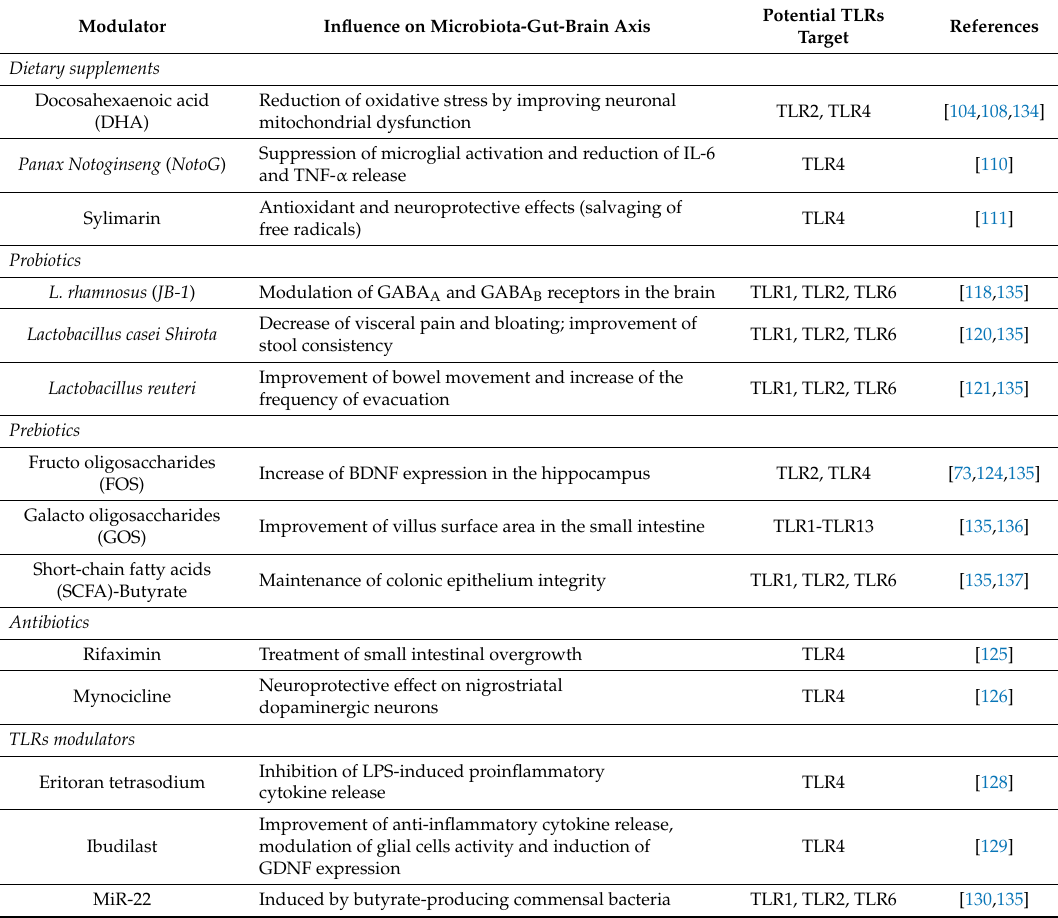
Table 1. Pharma- and/or nutraceuticals as potential modulators of the microbiota-gut-brain axis and Toll-like receptors (TLRs) signaling in the progression of pathology in Parkinson’s disease